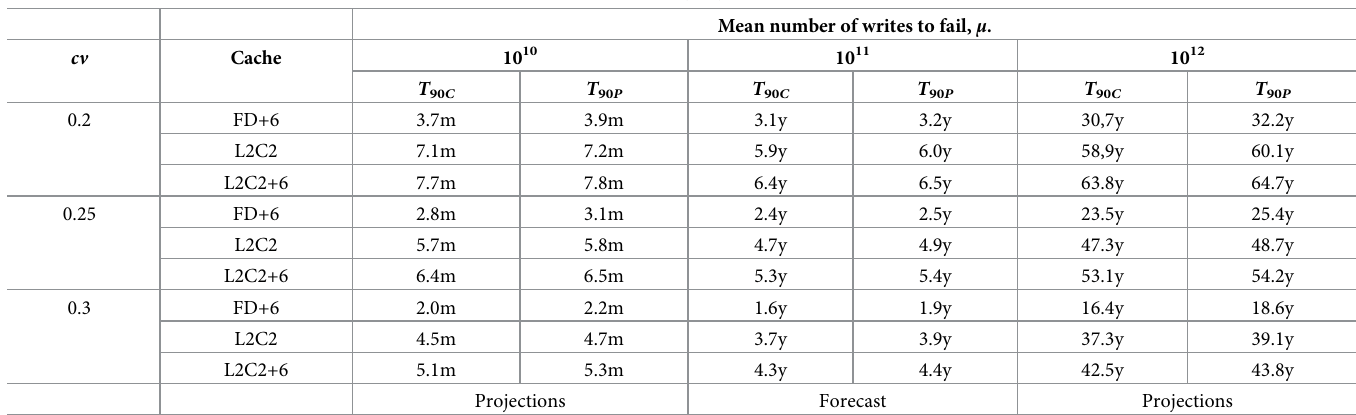
Table 8. T 90 and T 90 for FD+6, L2C2 and L2C2+6, varying cv and μ . m = months, y = years. C P